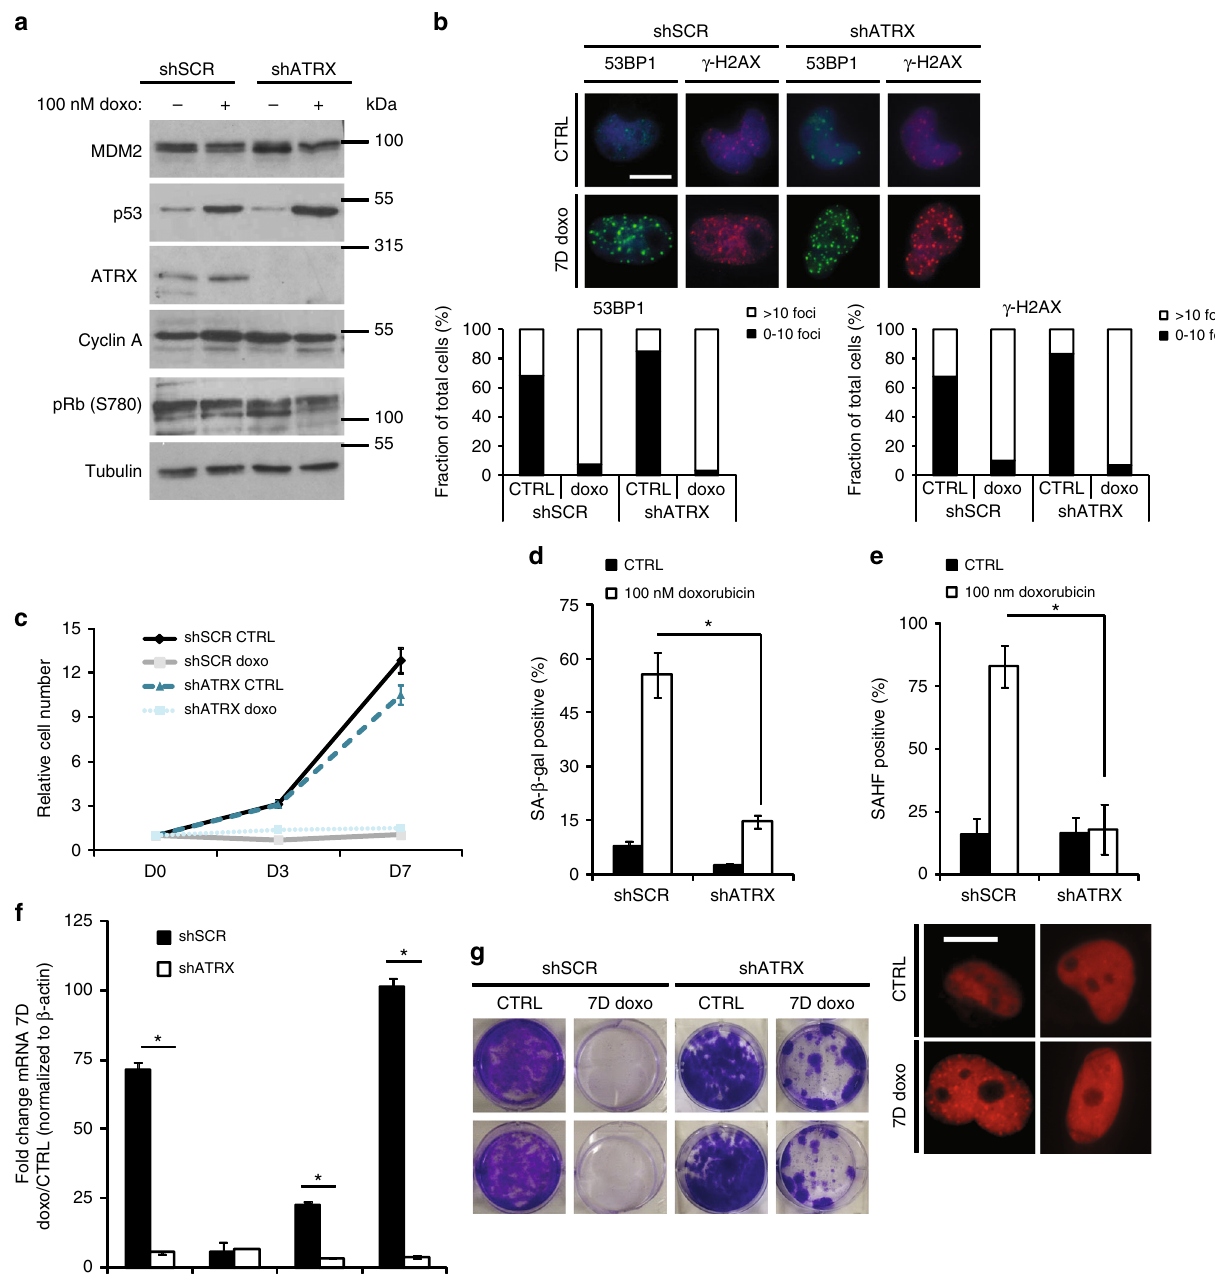
Fig. 1 ATRX is necessary for doxorubicin-induced senescence. LS8817 cells were transduced with either a scrambled (shSCR) or ATRX-speci fi c (shATRX) lentiviral knockdown vector and subsequently treated with 100 nM doxorubicin for 7 days. a Extracts were made from the cells indicated above each lane and the expression of proteins determined by immunoblot as indicated on the left of each panel. ATRX was detected with the D-5 antibody. b Cells were treated as described on the left and stained with the antibodies indicated on top of each panel. Representative images are shown ( top ) and quanti fi cation of the foci is plotted ( bottom ). c The indicated cells were plated on day 0 and either treated with 100 nM doxorubicin (doxo) or left untreated (CTRL). Cell number was counted at the indicated days and the relative number of cells is plotted. d , e The accumulation of SA- β -gal-positive cells ( d ) or SAHF-positive cells ( e ) for each individual treatment condition was measured. Representative SAHF images are shown ( below ). f The accumulation of four of the liposarcoma SASP transcripts was measured by qPCR under each indicated condition and their induction in doxorubicin treated cells relative to that in untreated cells is plotted and compared. g The cells were treated with 100 nM doxorubicin (7D doxo) or left untreated (CTRL) for 7 days. Cells were then collected, counted and replated at low density in the absence of drug. Clonogenic growth was measured by crystal violet staining 3 weeks later. Representative images from two independent experiments are shown. Colony number is not quanti fi ed as individual colonies could not be discerned. All data are plotted as mean ± SEM from at least three independent experiments. Asterisk indicates p < 0.05 using a two-sided Student ’ s t- test. All images were taken at the same magni fi cation. The scale bar is 20 microns. See also Supplementary Fig. 10 for uncropped